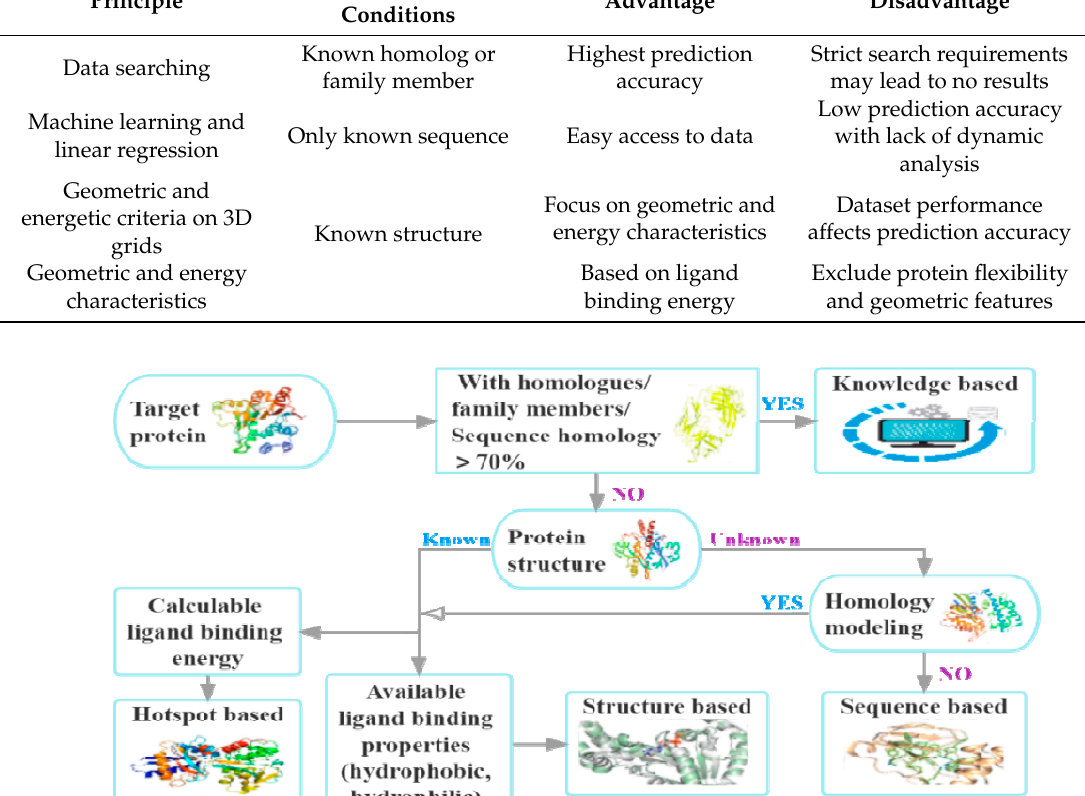
Table 3. Comparison of binding site identification and druggability evaluation.